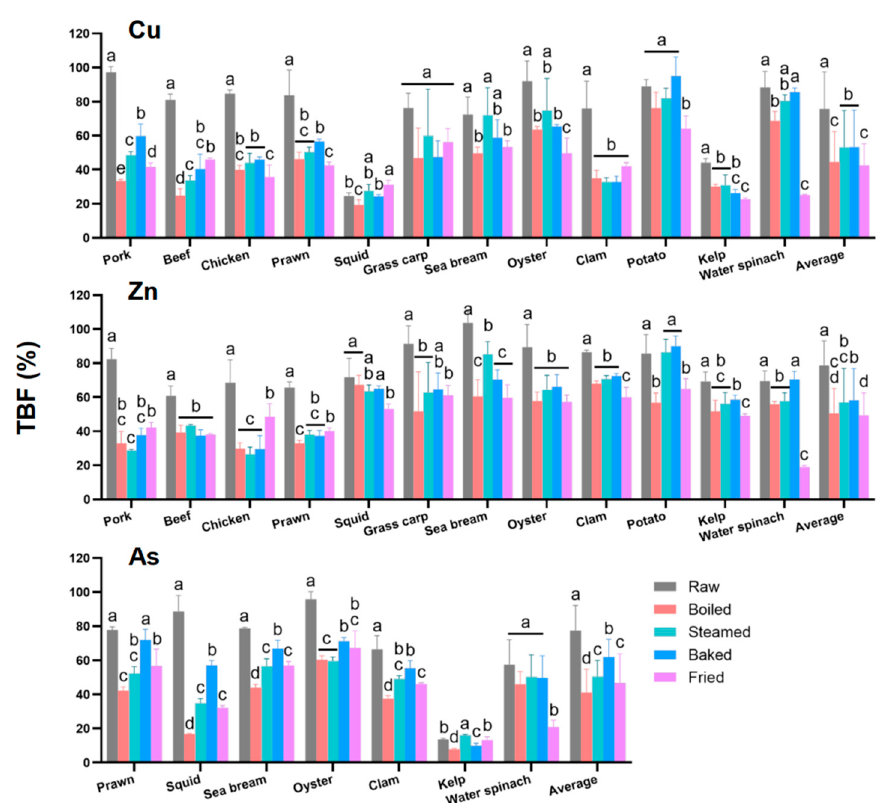
Figure 6. The total bioaccessible fraction (TBF) of Cu, Zn, and As in the food ingredients. The kelp is not considered when calculating the average TBF of As due to its low value. Data are expressed as means ± SD ( n = 3). Different letters (a, b, c, d, e) represent significant differences between treatments ( p < 0.05).